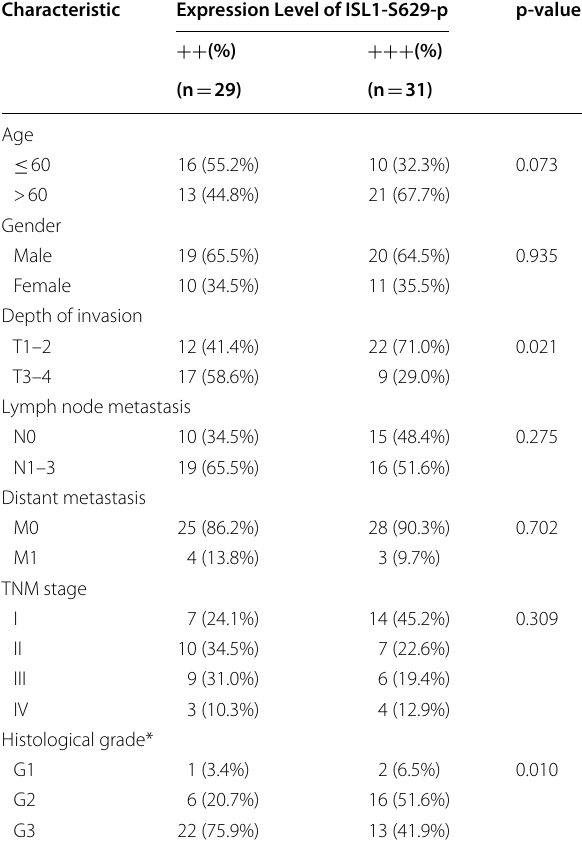
Table 3 Relationship between expression of ISL1-S629-p and clinic pathological parameters of gastric cancer